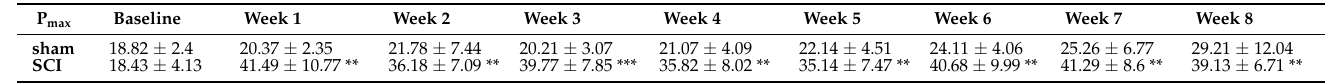
Table 1. P max in SCI vs. sham